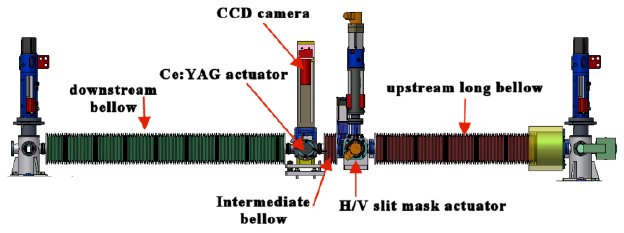
FIG. 5. (Color) A schematic view of the emittance-meter device. Beam direction is from right to left.